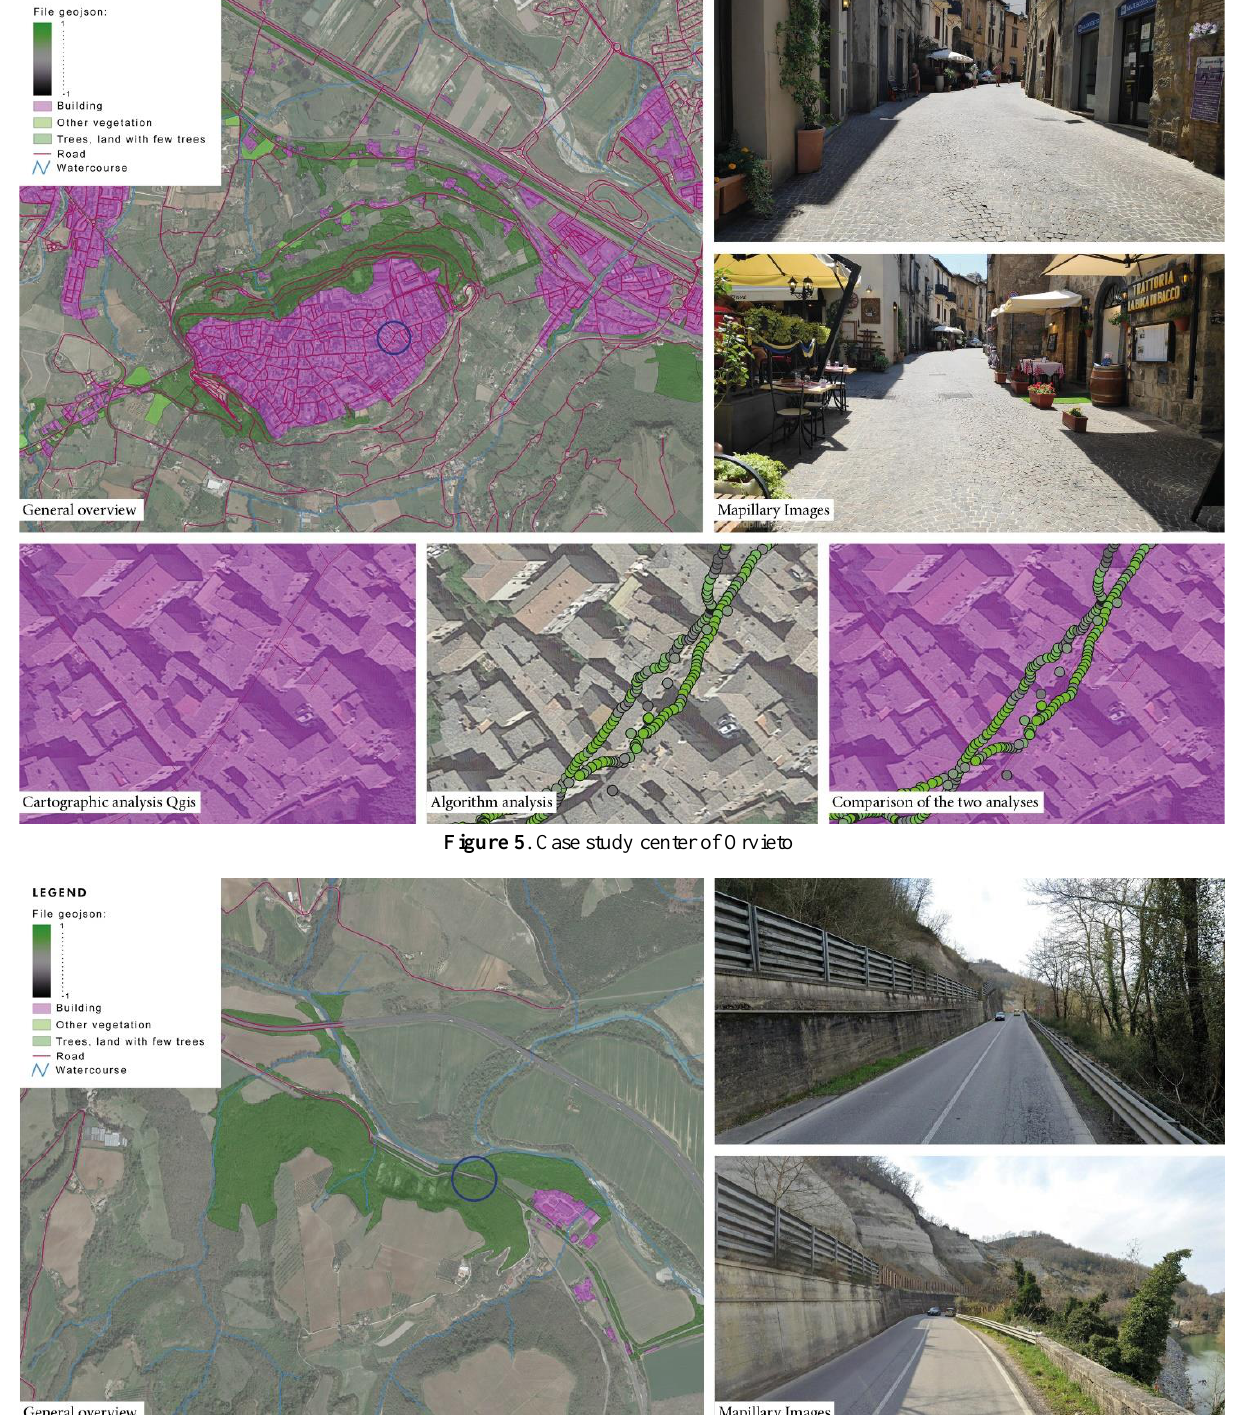
Figure 6 . Case study of